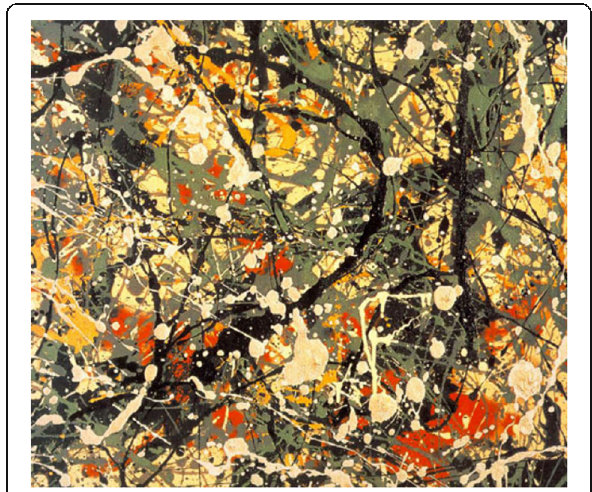
Fig. 19 A computer generated image of Pollock ’ s “ Number 8 ”